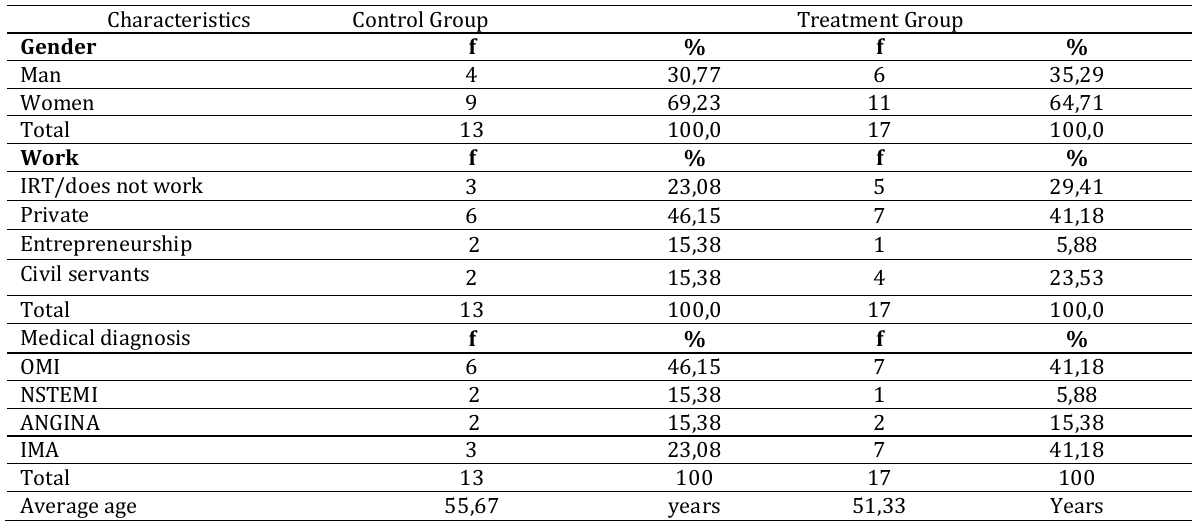
Table . Distribution of the characteristics of the coronary heart disease clients Characteristics